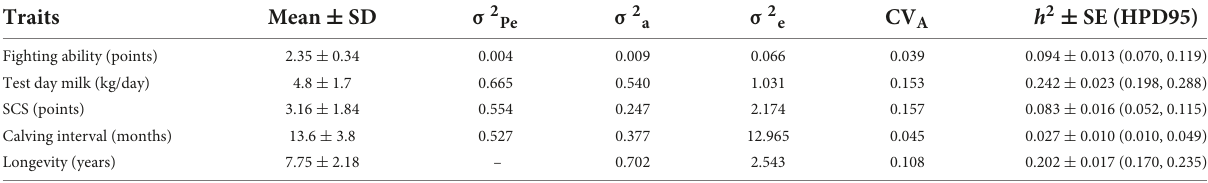
0.202 ± 0.017(0.170,0.235)